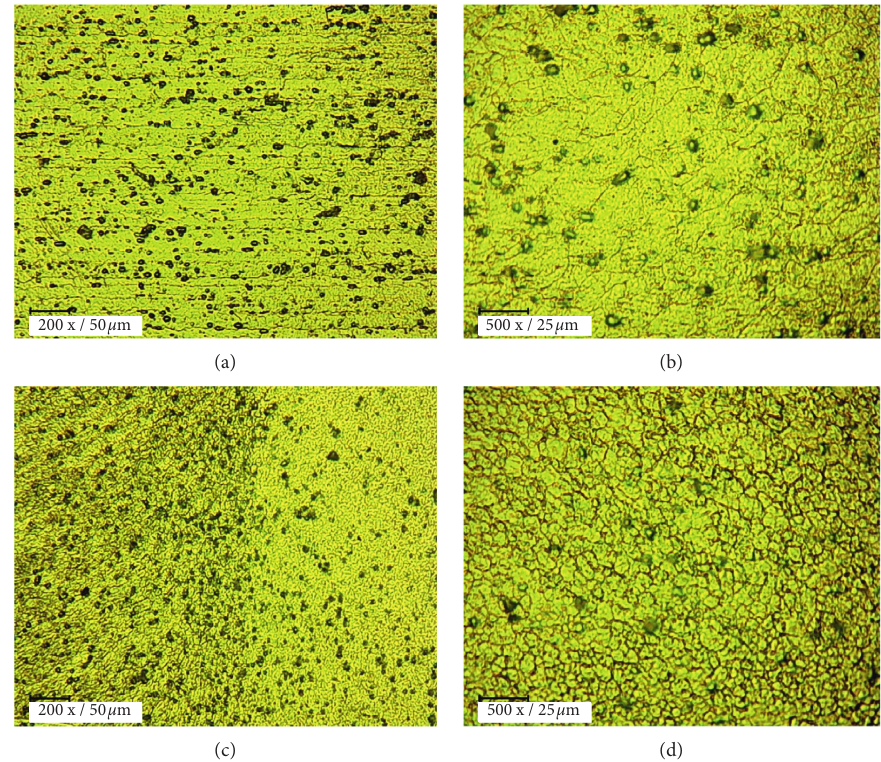
Figure 17: Detailed microscopic image for dry friction stir welding of AA 7075 aluminium alloy. (a) Parent. (b) HAZ. (c) Interface. (d) Weld nugget zone.